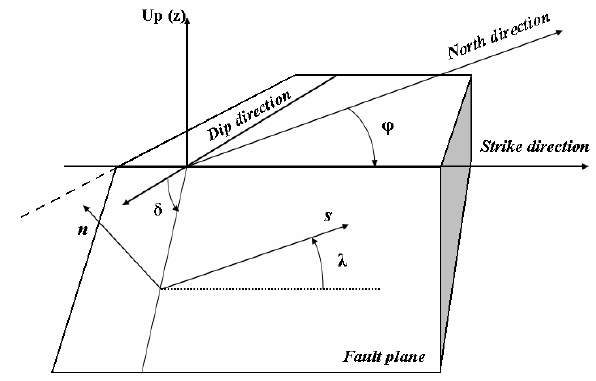
Figure 4. Geometrical illustration of fault plane, slip direction, the normal direction to the fault plane. The slip vector is the movement of the hanging wall block relative to footwall block.